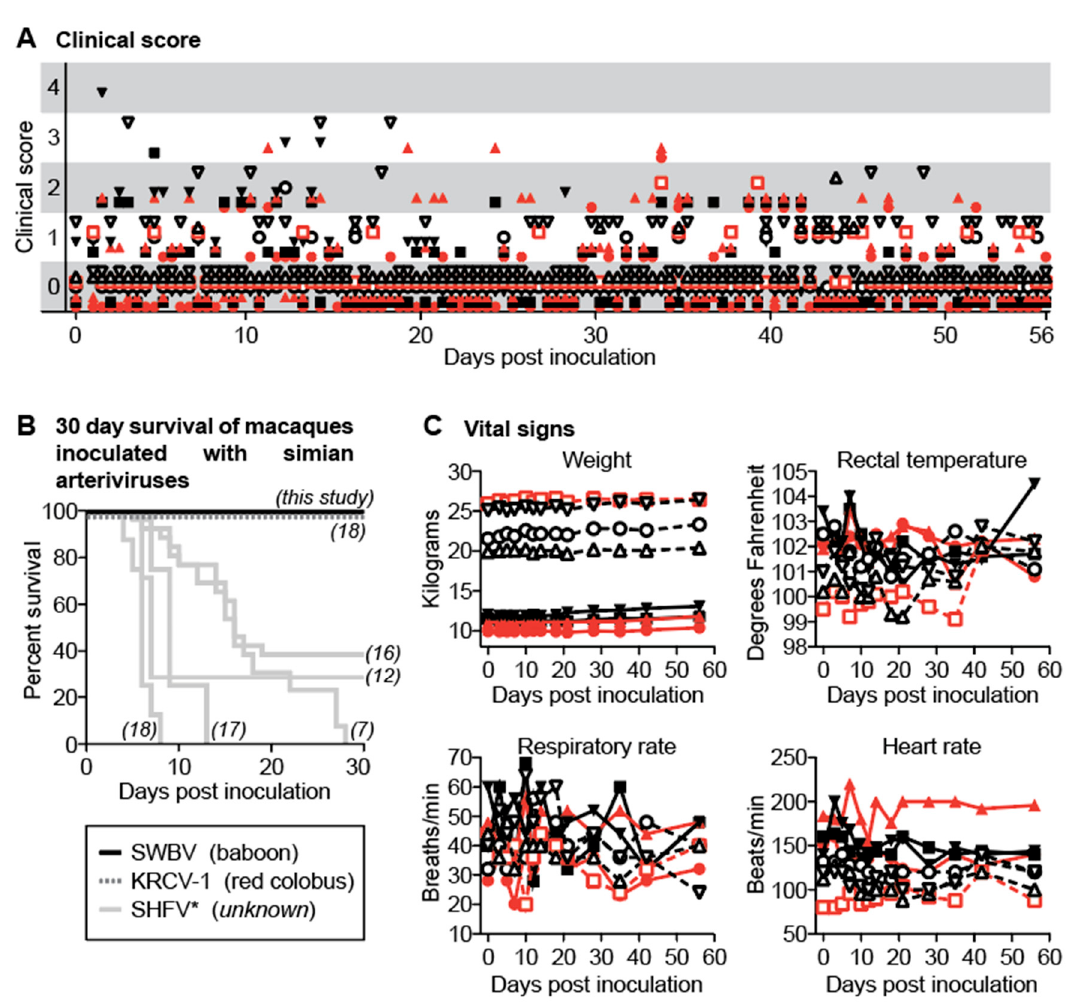
Figure 2. Clinical evaluation of baboons and macaques inoculated with SWBV. ( A ) Animals were evaluated for signs of disease twice per day using a comprehensive clinical scoring rubric in which a score of <5 was deemed within normal limits. ( B ) For macaques, mortality was also assessed (black line) and compared to previous studies of simarterivirus infection in macaques (corresponding references in italics); the virus and hosts for the simarteriviruses shown are found below the graph in parentheses (SHFV has an asterisk because the natural host is not known and the sequence identity of the viruses used in some of these studies has never been confirmed). Vital signs for baboons and macaques are shown in ( C ). Macaques are shown as solid symbols with solid lines, baboons are shown as open symbols with dashed lines; infected animals are shown in red and uninfected animals are shown in black.